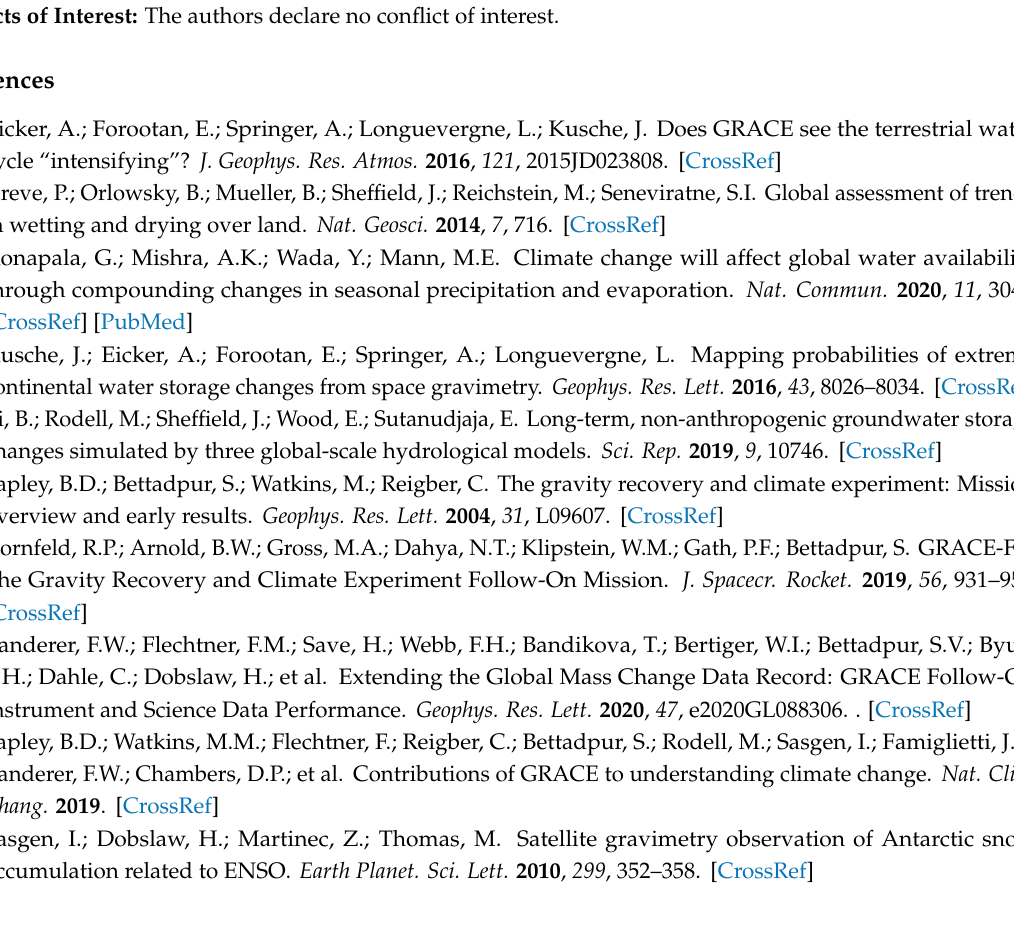
Figure S1: Regions influenced by surface water, groundwater storage, or glaciers, Figure S2: Identification of independent CMIP6 models, Figure S3: Example for GRACE TWS time series decomposition, Tables S1–S7: Statistics for amplitude, phase, interannual RMS, their changes, and the linear trend in different climate zones, Figure S4: Illustration of phase averaging, Figure S5: Illustration of interference of mrso and snw phases, Figure S6: Ranking of ensemble members, Figure S7: Detectability of annual cycle changes for a specific CMIP6 model